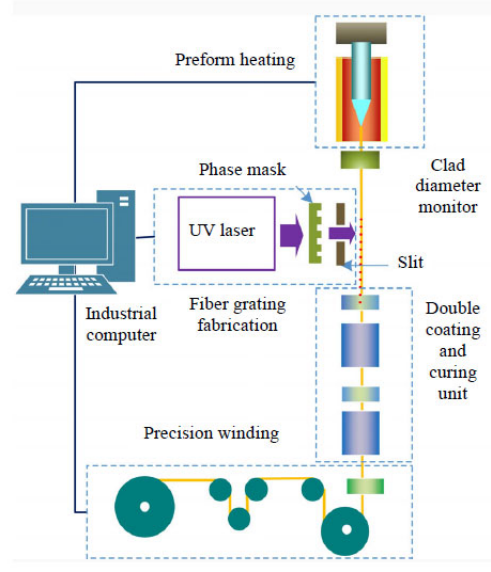
Fig. 1 Diagram for DTGs fabrication experimental setup.